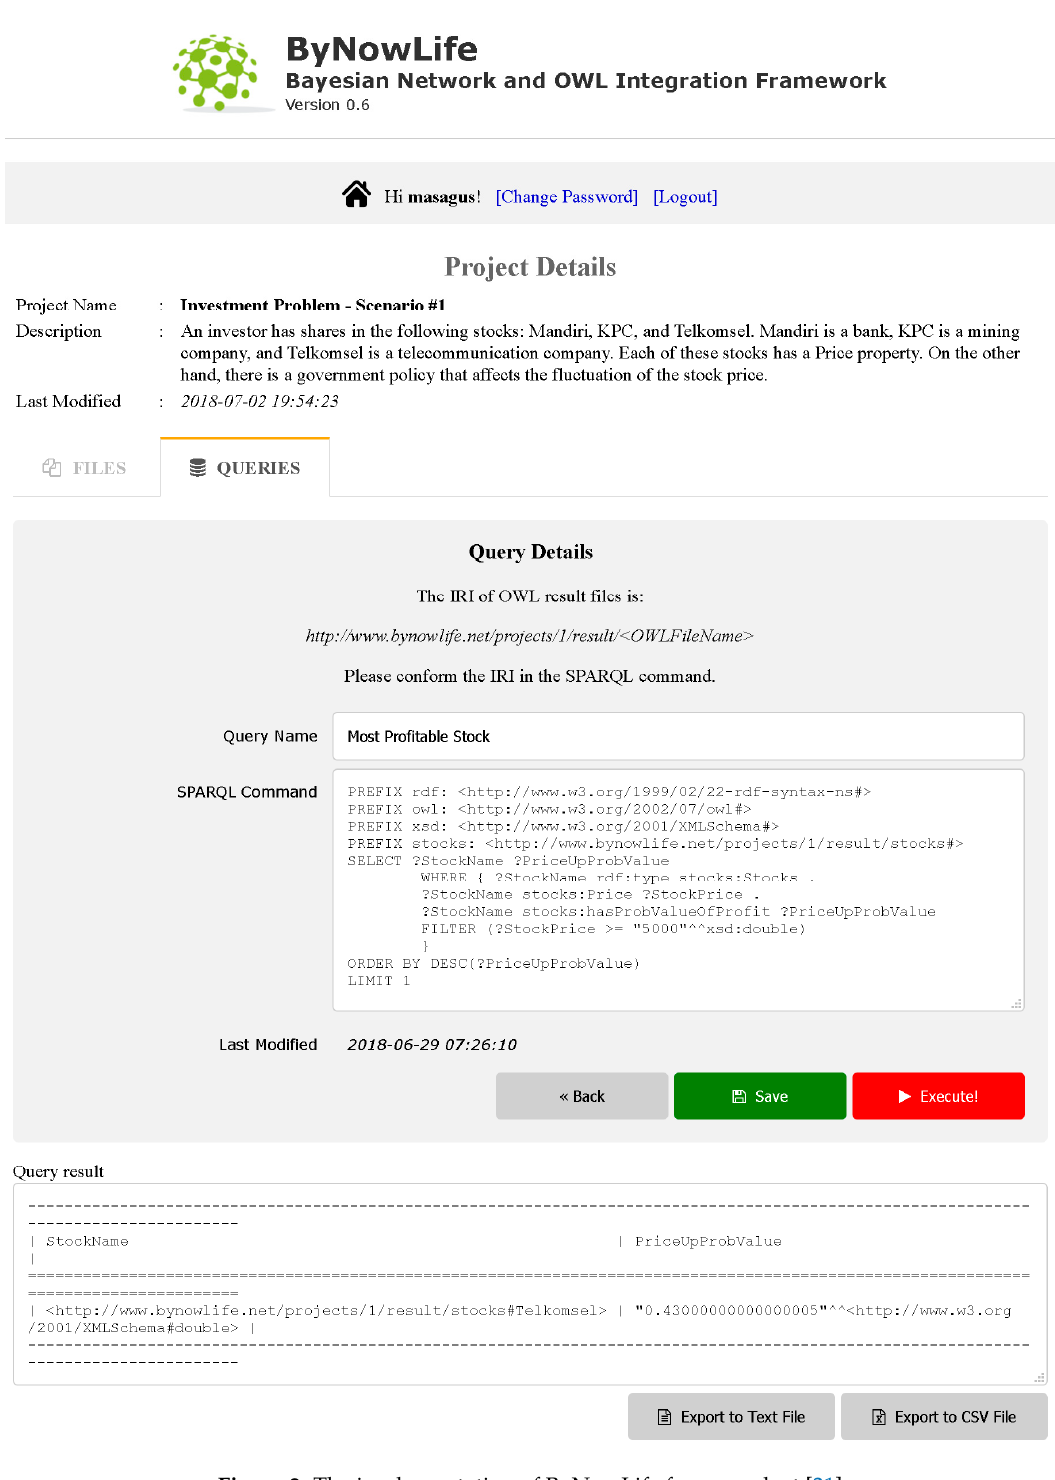
Figure 2. The implementation of ByNowLife framework at